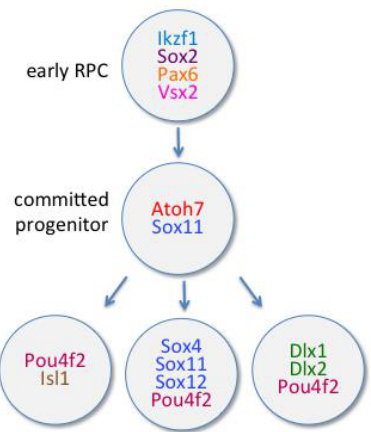
Figure 2. Transcription factors participating in the specification of RGCs from early retinal progenitor cells (RPC) to committed progenitors that will later produce postmitotic RGCs.